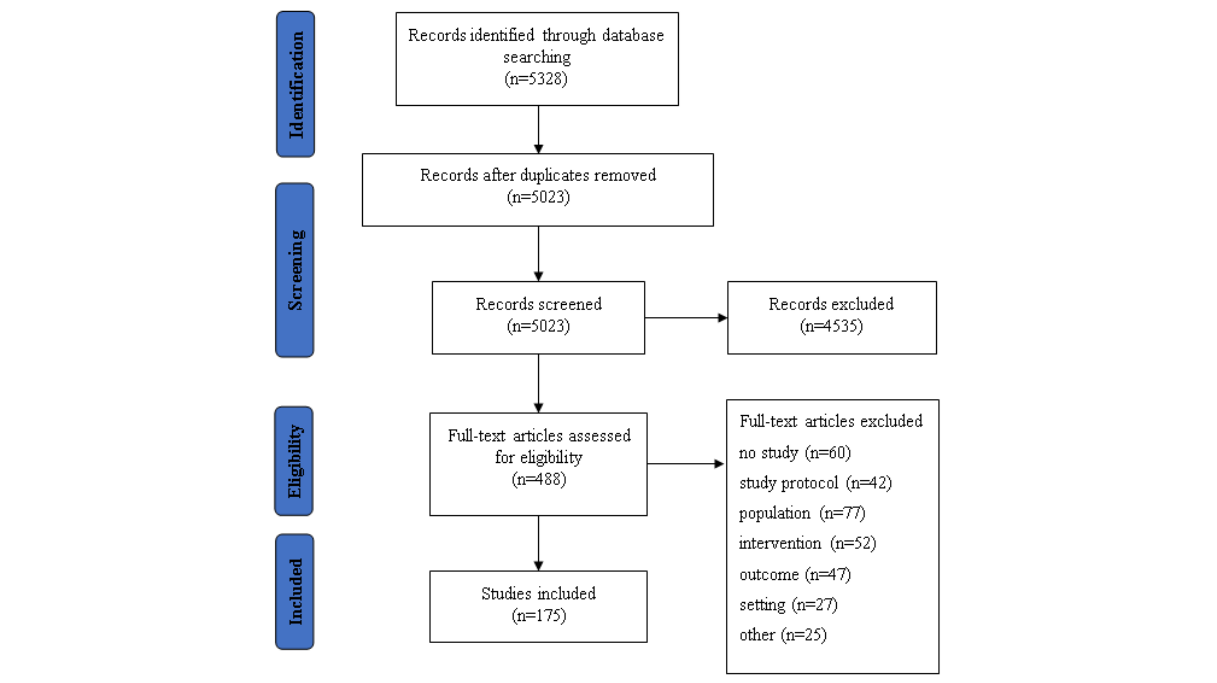
Figure 1. PRISMA